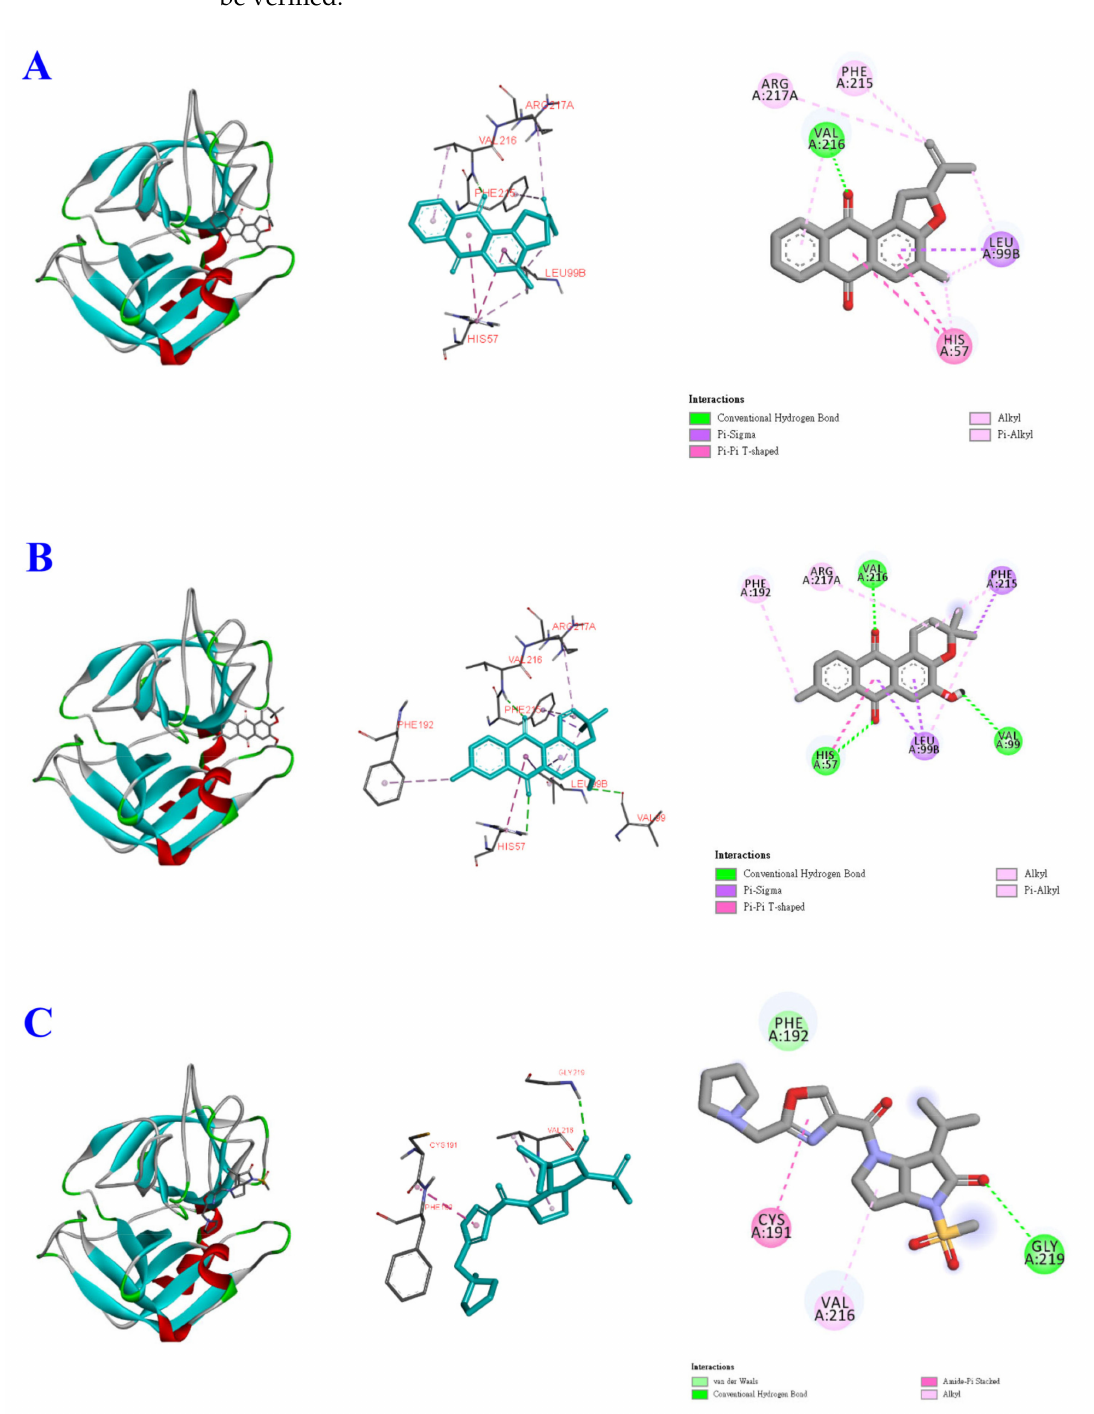
Figure 3. In silico modeling of ( A ) 1 , ( B ) 5 , and ( C ) GW475151 docking into the human neutrophil elastase